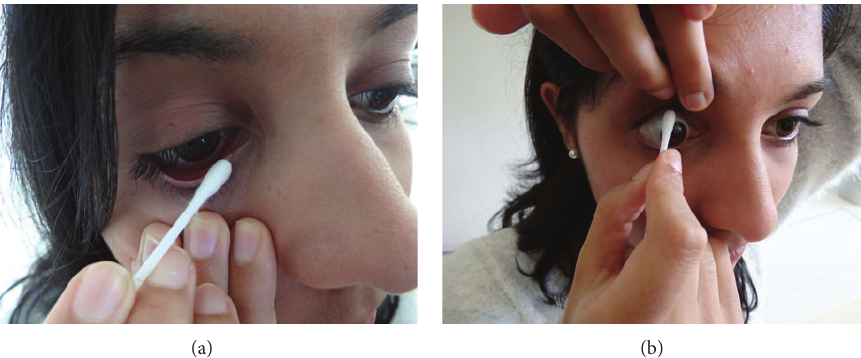
Figure 3: (a) Lid scrubs (Part B of PBMP) of the right lower lid (RLL) using a Cb on the lid margin. (i) The patient’s lid and hand have been dried and degreased by wiping with a tissue prior to lid scrubbing. (ii) In this photograph, the patient is applying lid scrubbing to the medial 1/5 of the RLL for 3 seconds. (iii) Note that the lower lid is everted adequately enough to protect the cornea, allowing precise access to its horizontal margin. (v) Note also that the Cb is held at the optimal distance from its tip to optimise patient control of the Cb tip. (b) The “Gorilla Grip” used to evert the right upper lid (RUL) away from ocular surface. (i) Note that the patient is using the Gorilla Grip on the RUL by means of the nondominant hand and middle finger. (ii) The patient is carefully inspecting the RUL with the opposite eye. (iii) The lid margin is consistently kept at least 3mm from the globe. (v) In this photograph, the patient is carrying out PBMP on the middle 20% of the RUL. Each of the theoretical five segments of each lid takes 3 seconds.